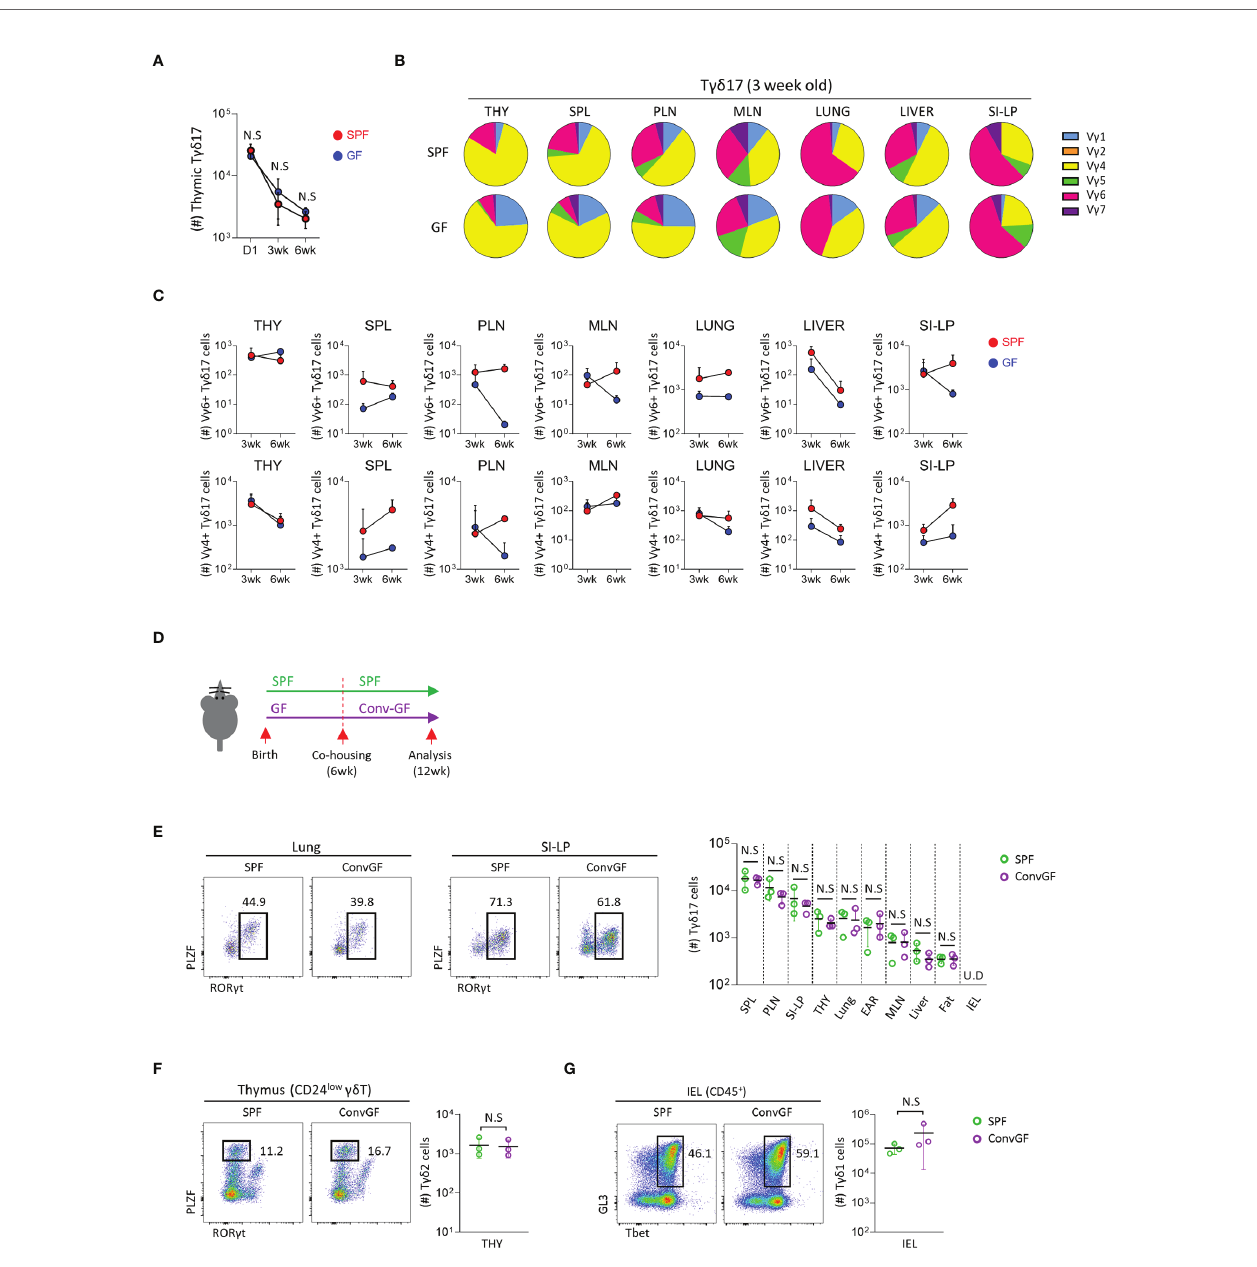
FIGURE 2 | Microbial stimulation restores peripheral pool of T gd 17 cells. Single cell suspension of indicated organs from SPF, GF and conventionalized GF B6 mice were analyzed by fl ow cytometry. (A) Graph shows statistical analysis of absolute number of thymic T gd 17 cells at indicated ages. (B, C) Three and six week-old SPF and GF mice were analyzed using fl ow cytometry. (B) Pie charts show mean frequencies of each V g TCR among total T gd 17 cells in indicated tissues from SPF and GF 3-week-old B6 mice (N = 3). (C) Graphs show statistical analysis of V g 6 + and V g 4 + T gd 17 cells in indicated tissues from SPF and GF mice (N = 3). (D – G) GF mice were conventionalized by co-housing with SPF mice for 6 weeks (ConvGF) and analyzed. (D) Experimental scheme is shown. (E) Representative dot plots show T gd 17 cells in the lung and SI-LP from SPF and ConvGF mice. Graph shows statistical analysis of absolute number of T gd 17 cells indicated tissues. (F) Representative dot plots show thymic T gd 2 cells and graph shows statistical analysis of their absolute numbers. (G) Representative dot plots show IEL T gd 1 cells and graph shows statistical analysis of their absolute numbers. Numbers indicate frequencies of cells in adjacent gates and each dot represents an individual mouse. Error bars indicate ± SD. Pooled results from three independent experiments are shown. U.D, undetected. Unpaired two-tailed t -test was used. N.S, not signi fi cant ; SPF, speci fi c pathogen free; GF, germ-free; THY, Thymus; SPL, Spleen; PLN, peripheral lymph node; MLN, mesenteric lymph node; SI-LP, small intestinal lamina propria; IEL, intraepithelial